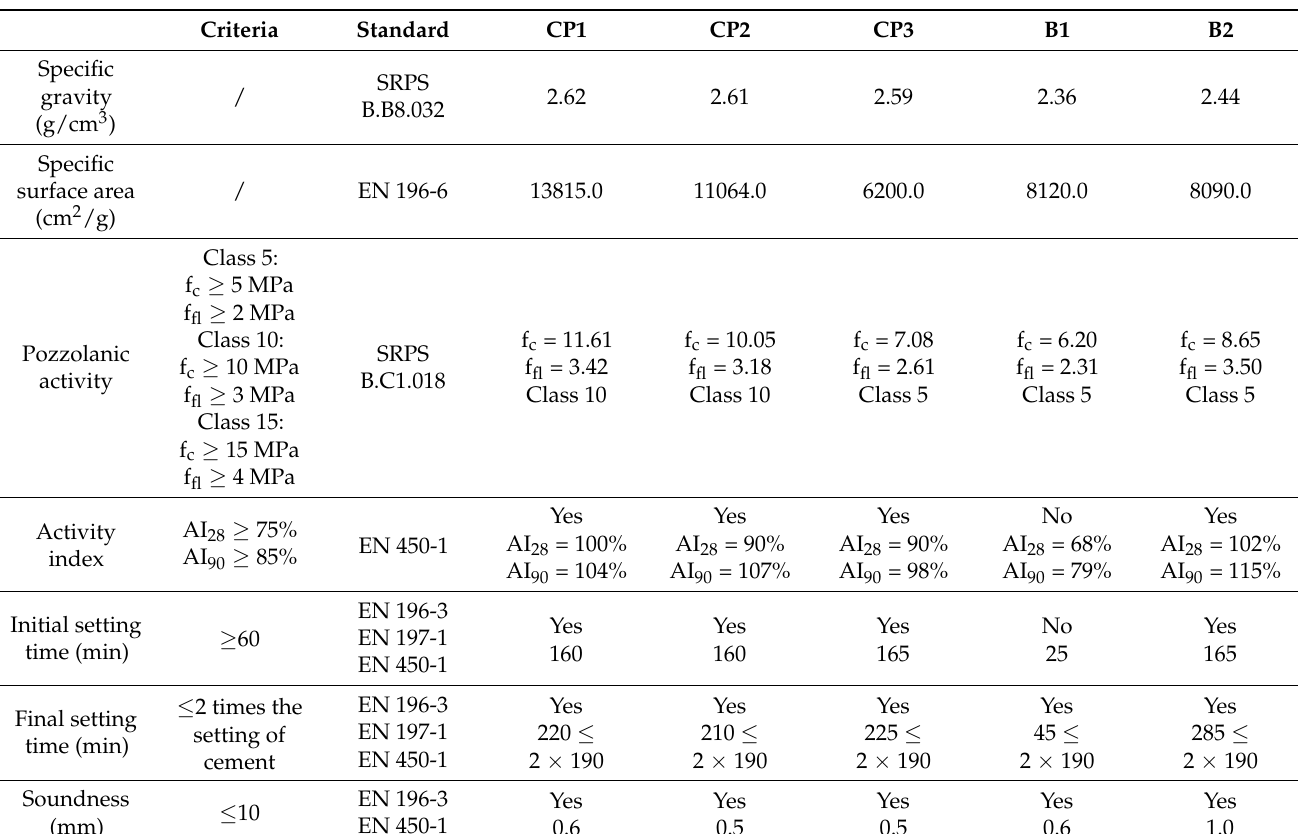
Table 5. Physical and pozzolanic properties of tested